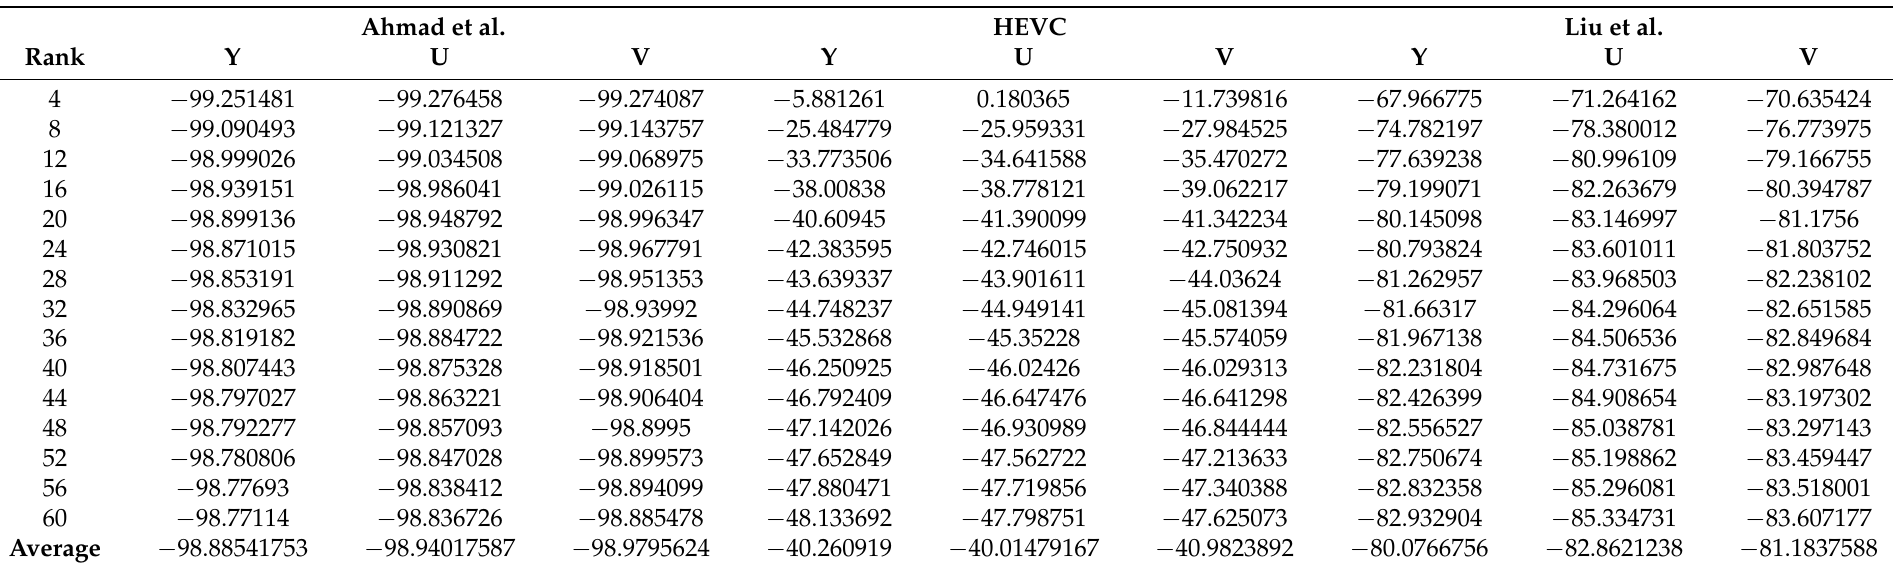
Table 3. Bjontegaard percentage rate savings for the proposed compression scheme with respect to Ahmad et al., HEVC codec, and Liu et al. (negative values represent gains) on Bikes data. Ahmad et al. HEVC Liu et